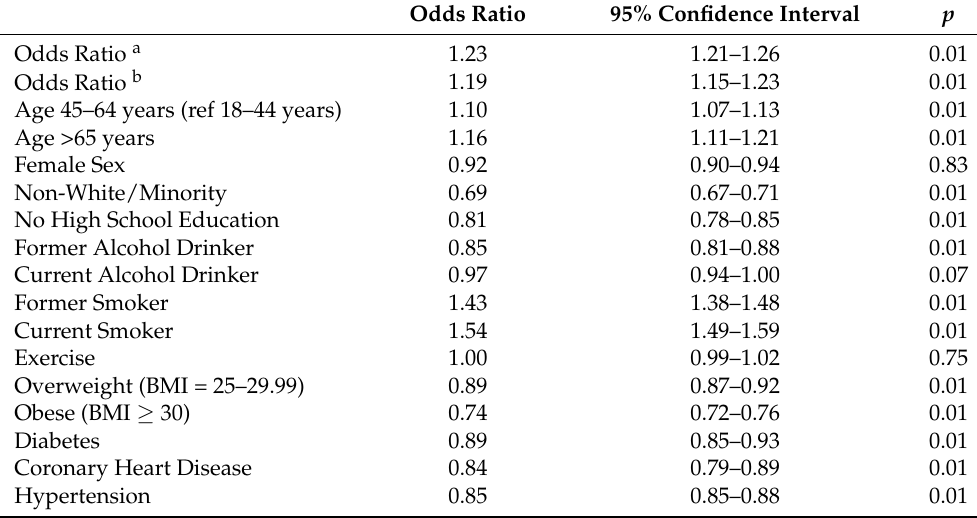
Table 2. Logistic regression for foreign-born status and healthy sleep (7–8